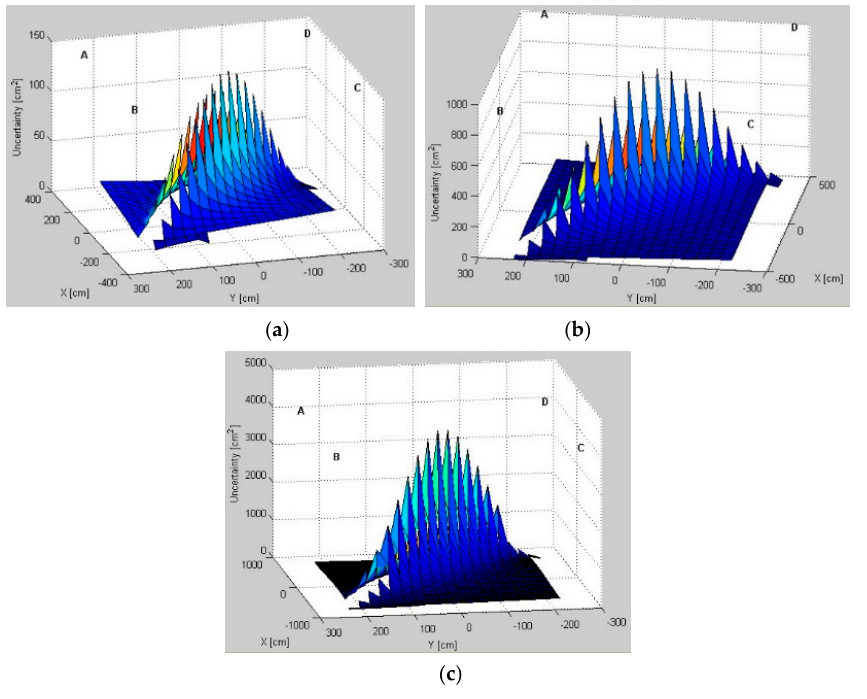
Figure 7. Uncertainty distributions for location sensors BD in ( a ) test environment TE1 ; ( b ) test environment TE2 ; and ( c ) test environment TE3 .